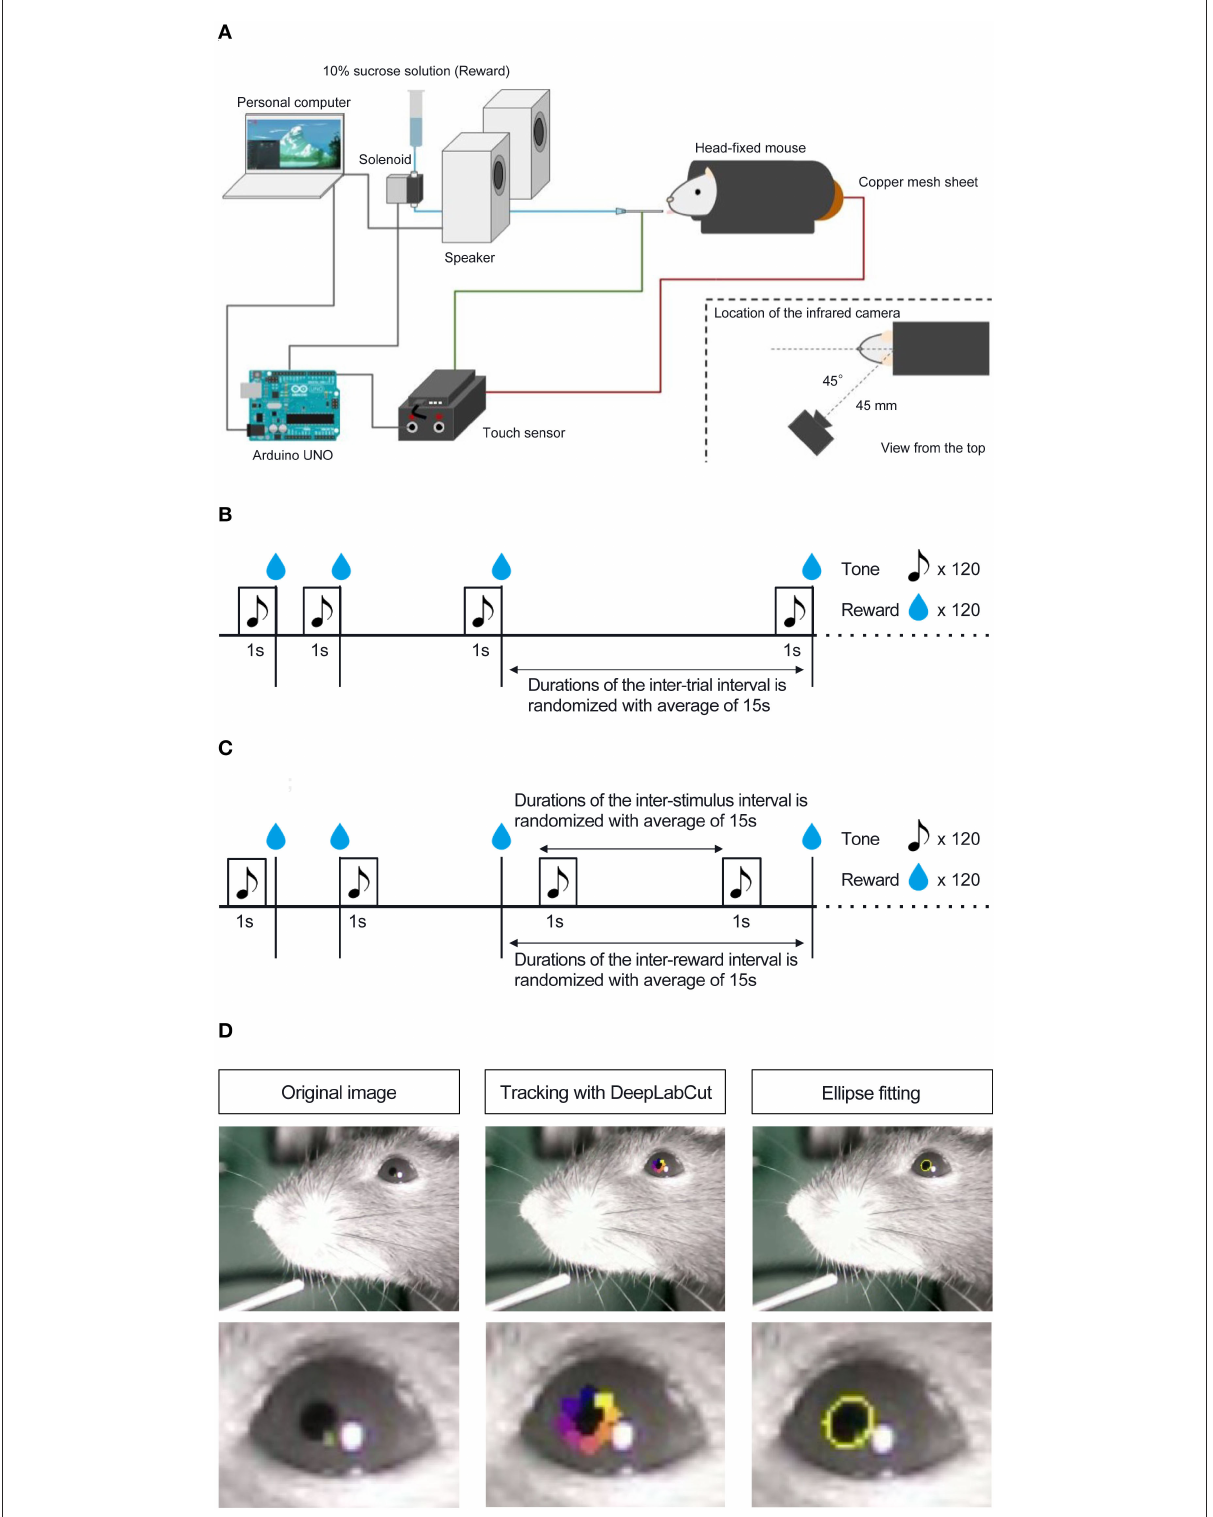
FIGURE1 Schematic representation of head-fixed apparatus, Pavlovian delay conditioning task, and pupillometry. (A) Schematic representation of the head-fixed experimental apparatus and the custom-made experimental control system. (B) Contingent group. In this group, the 1s